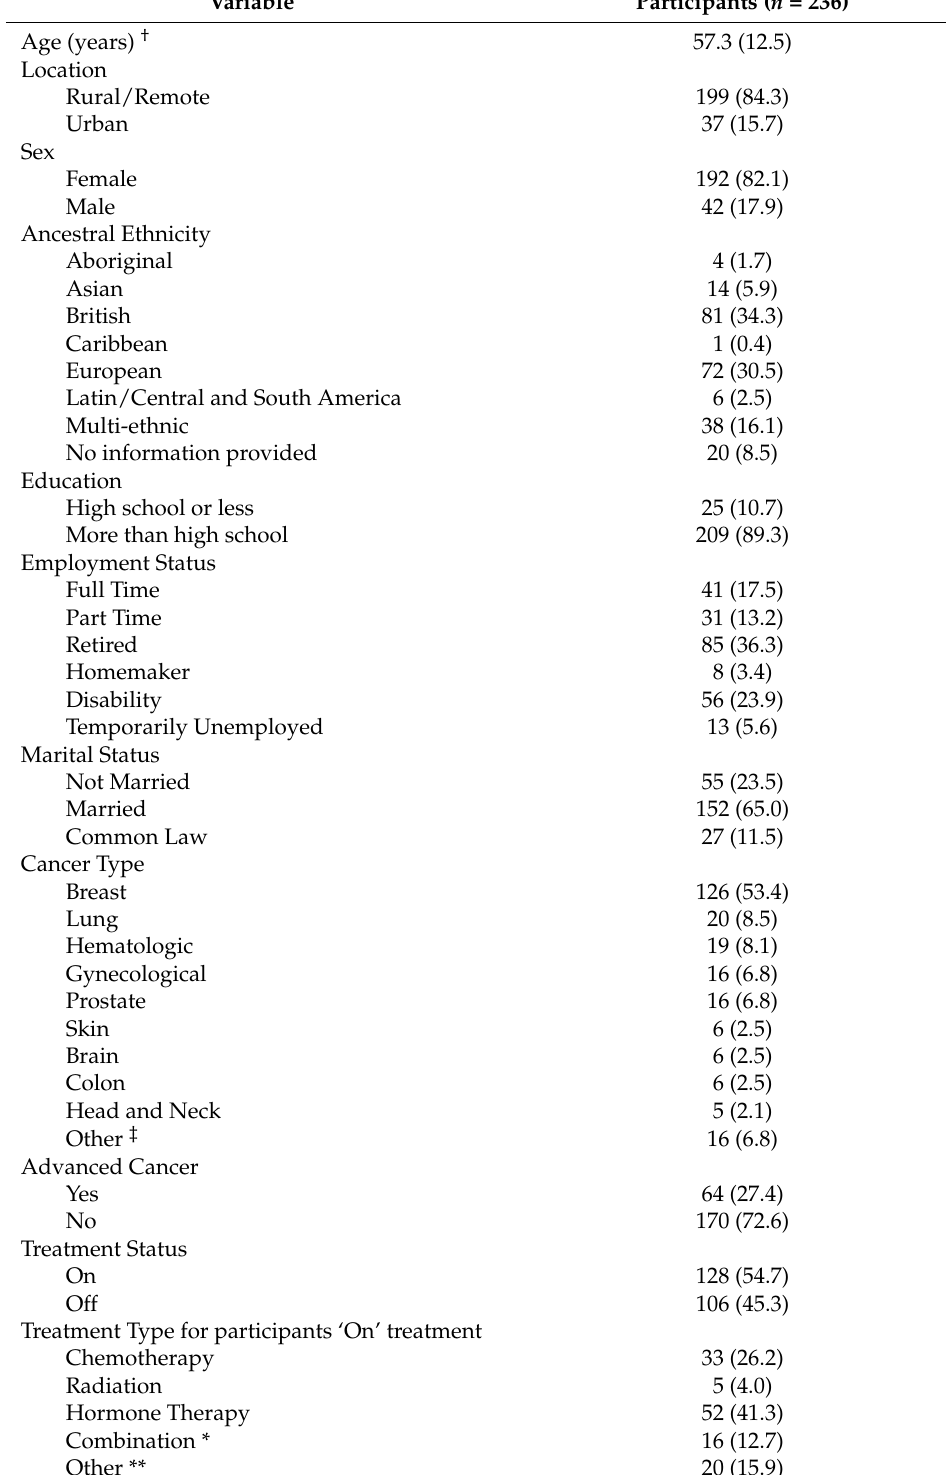
Table 1. EXCEL participant demographics and clinical characteristics—number